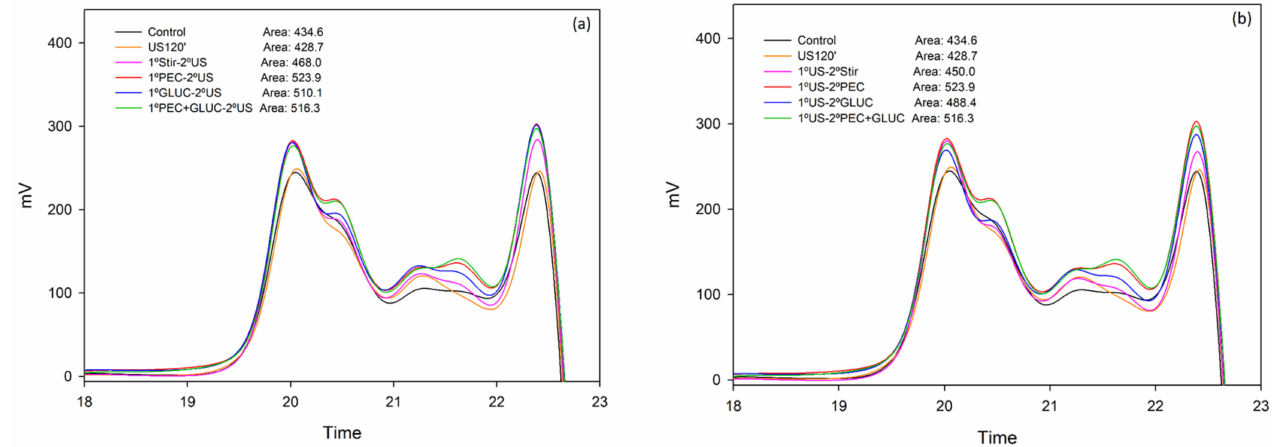
Figure 4. Mass distribution of the polysaccharides released from lees analyzed by SEC in the elution time comprised between 12 and 20 min. ( a ) Comparison of polysaccharides composition released when the enzyme treatments were added first and US treatment second. ( b ) Comparison of polysaccharides composition released when the US treatment was used first and enzyme treatments were added second. This figure was made in SigmaPlot